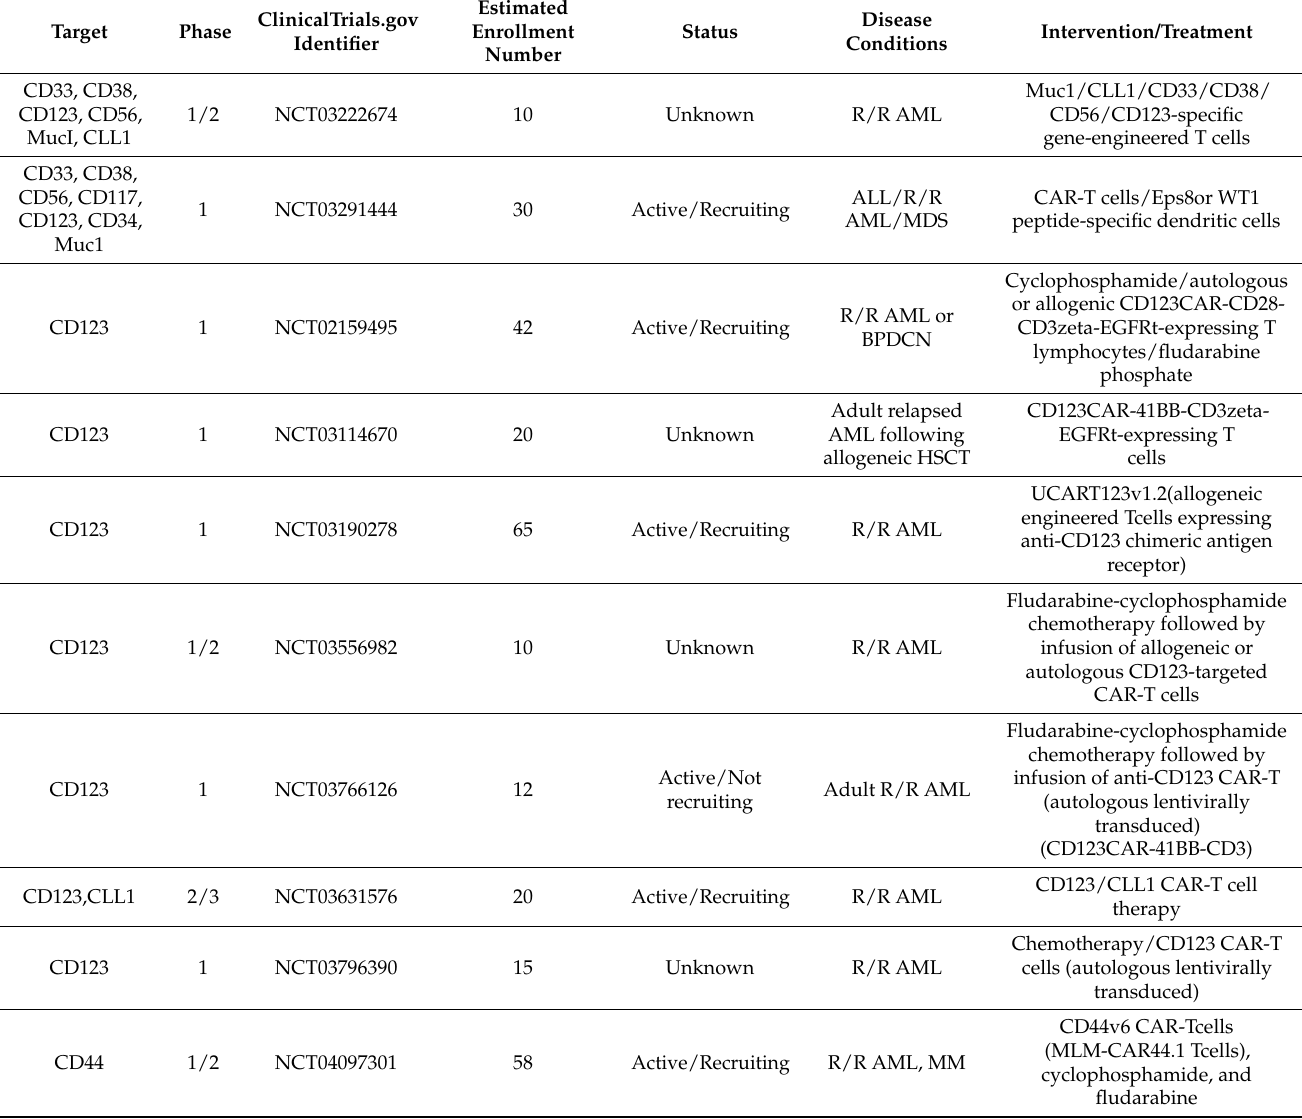
Table 2. Ongoing clinical trials of CAR-Tcell